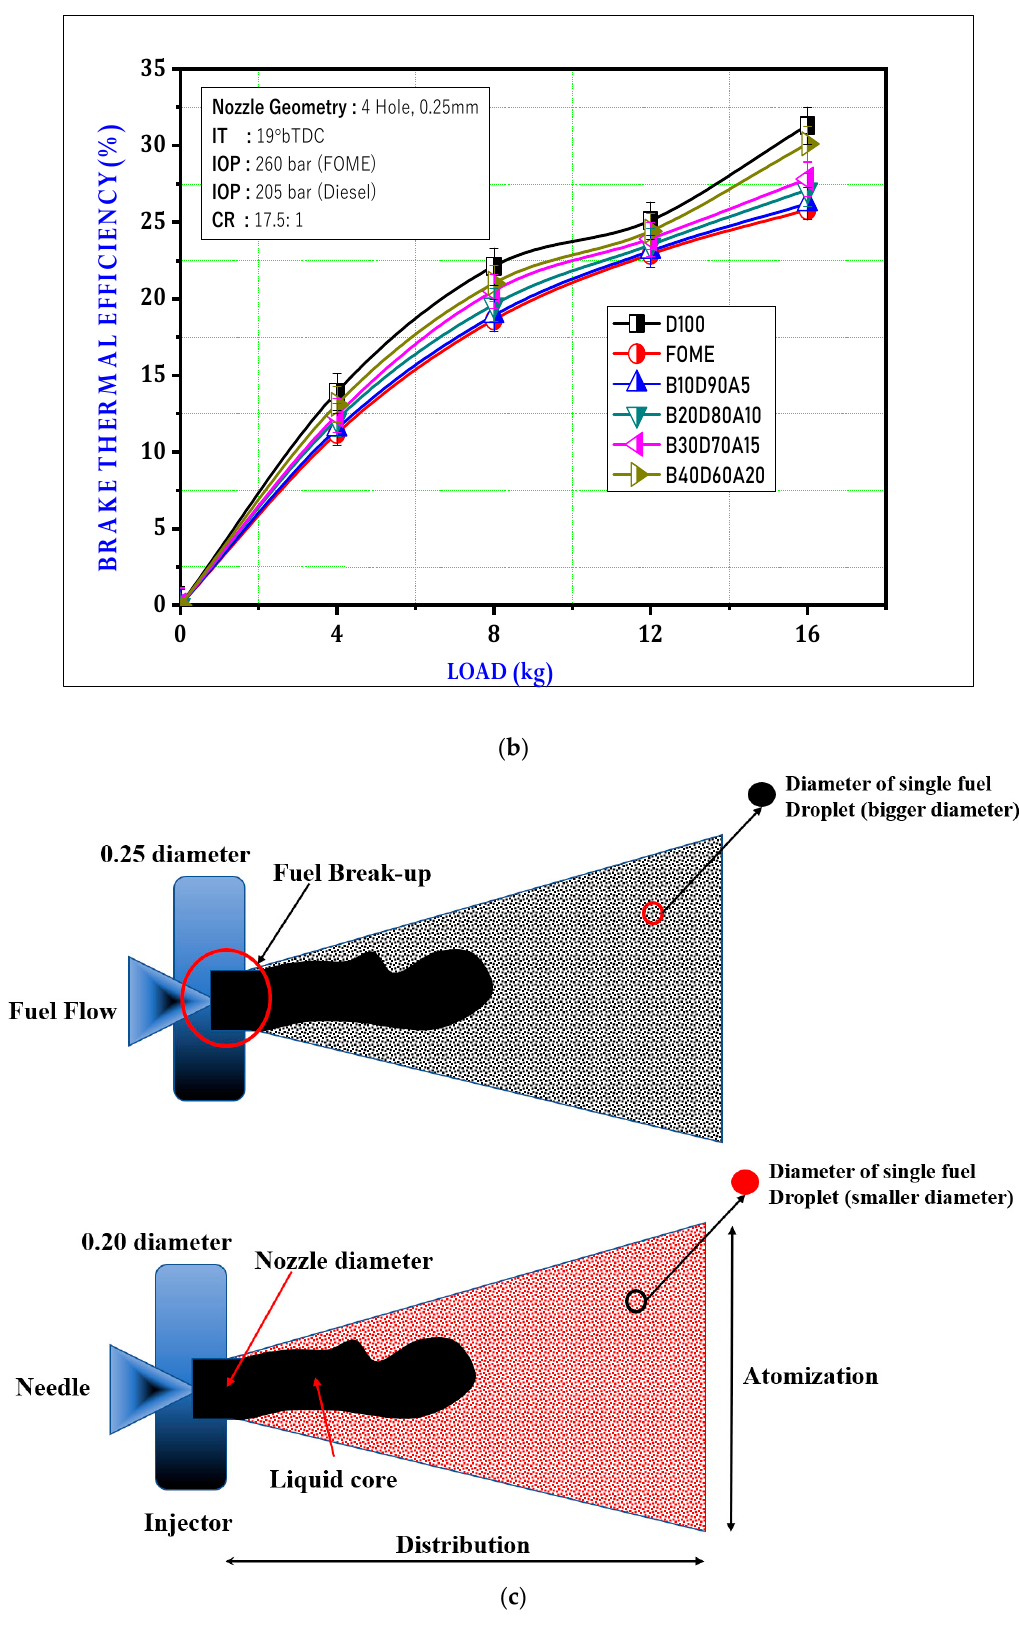
Figure 8. ( a ) BTE Variation with load for 4 holes at 240 bar. ( b ) BTE Variation with load for 4 holes at 260 bar. ( c ) Fuel droplet diameter and atomization as per the nozzle diameter [36].